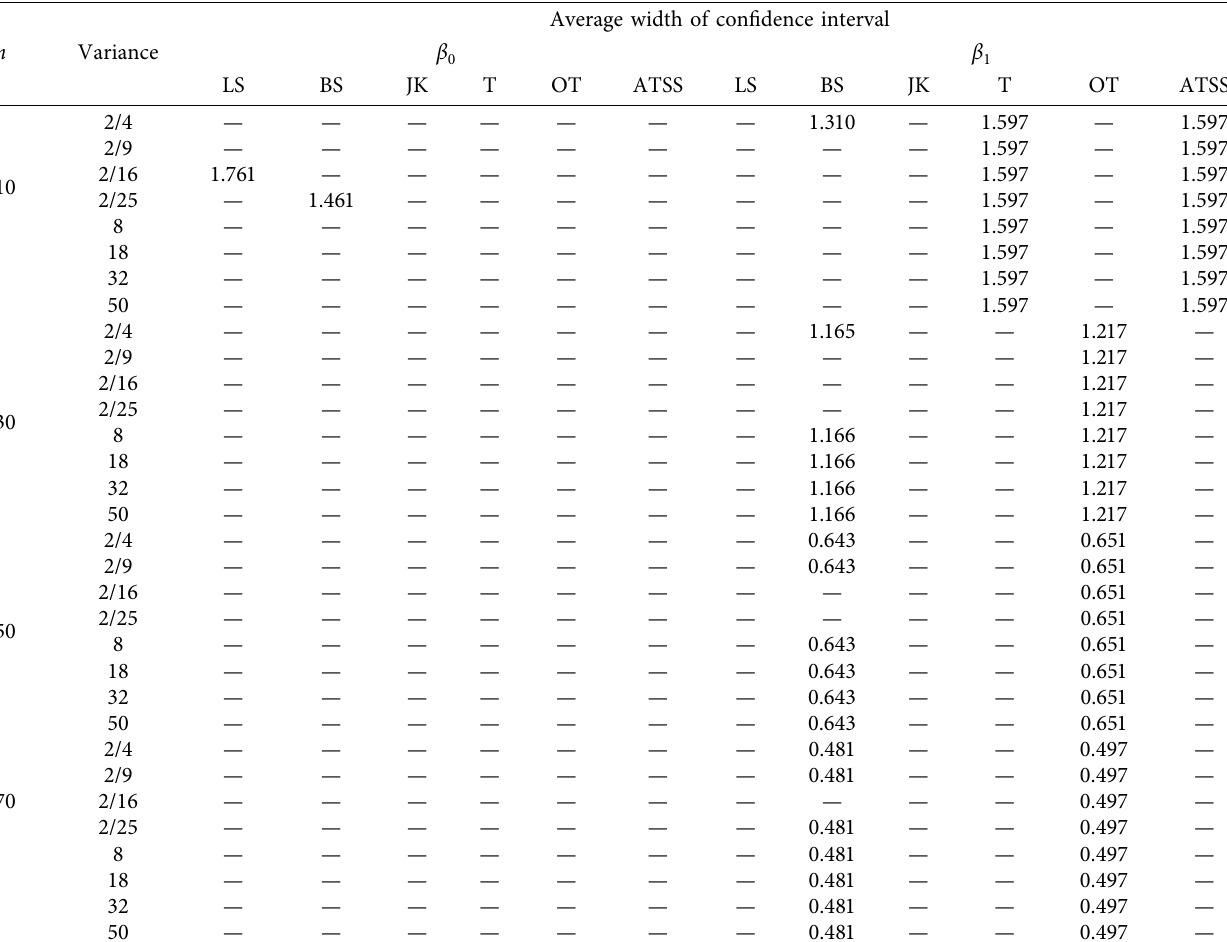
Table 5: The average width of the confidence interval for the independent variable and the error have gamma distributions with mean of 2/2, 2/3, 2/4, 2/5, 4, 6, 8, and 10 and variance of 2/4, 2/9, 2/16, 2/25, 8, 18, 32, and 50; sample sizes are 10, 30, 50, 70, 100, and 200.